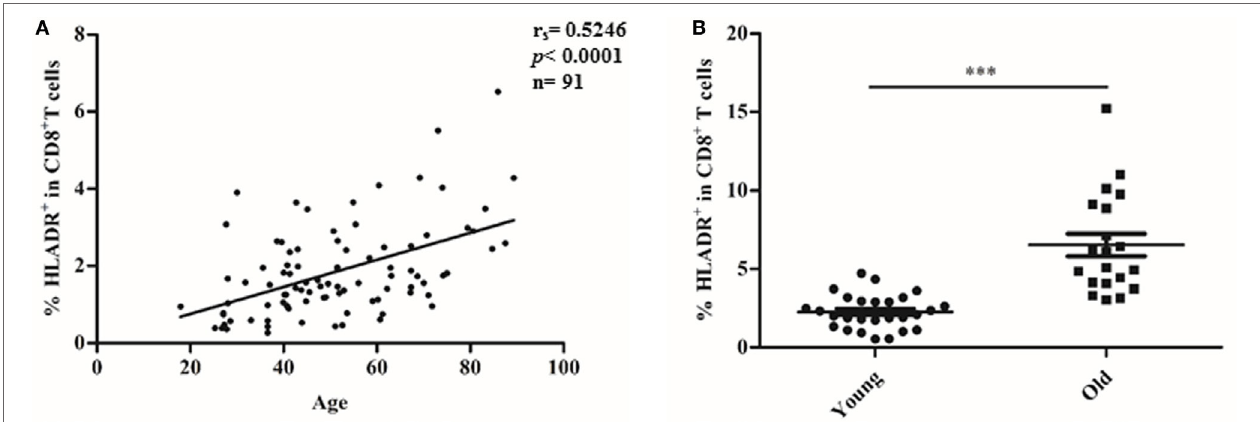
FigUre 1 | CD8 + human leukocyte antigen–antigen D related (HLADR) + T cells increase with age. HLADR + cells (%) within CD3 + CD8 + (100%) were measured by FACS analysis. (a) Correlation of CD8 + HLADR + cells in 91 female donors from Sardinia with age. Relationship between CD8 + HLADR + T cells (%) and age was assessed by Spearman correlation analysis; ( r s ), p value, and sample size ( n ) are indicated in (b) CD8 + HLADR + T cells in young vs elderly donors from Austria. Mean ± SEM are indicated for each group; young ( < 30 years), n = 26, old ( ≥ 70 years), n = 20. Statistical significance was assessed by Mann–Whitney test, *** p <